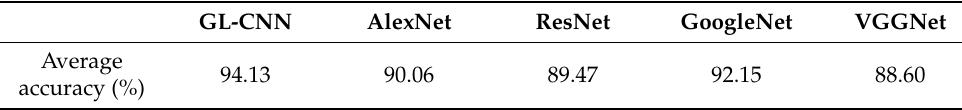
Table 2. Average accuracy of each